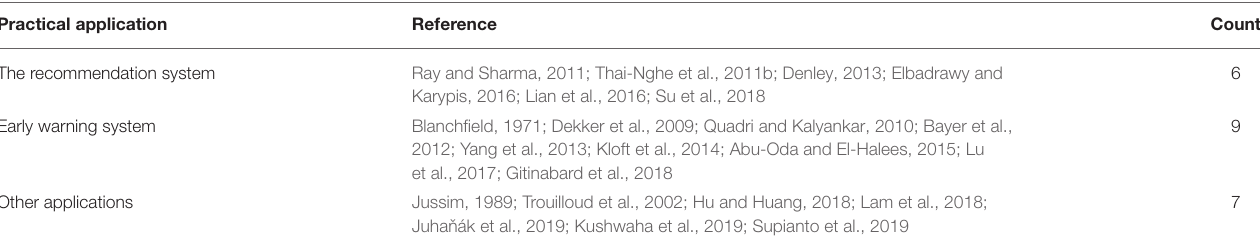
TABLE 4 | The list of references of the practical application of SPP.